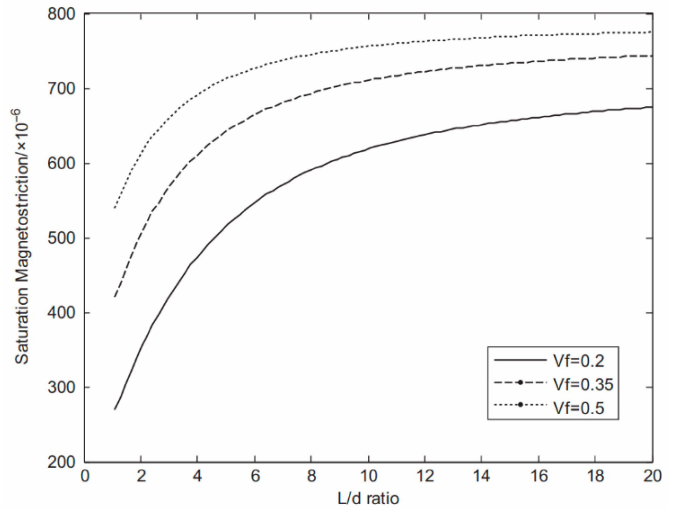
Figure 20. Relationship between saturation magnetostriction and particle aspect ratio of composites with different particle volume